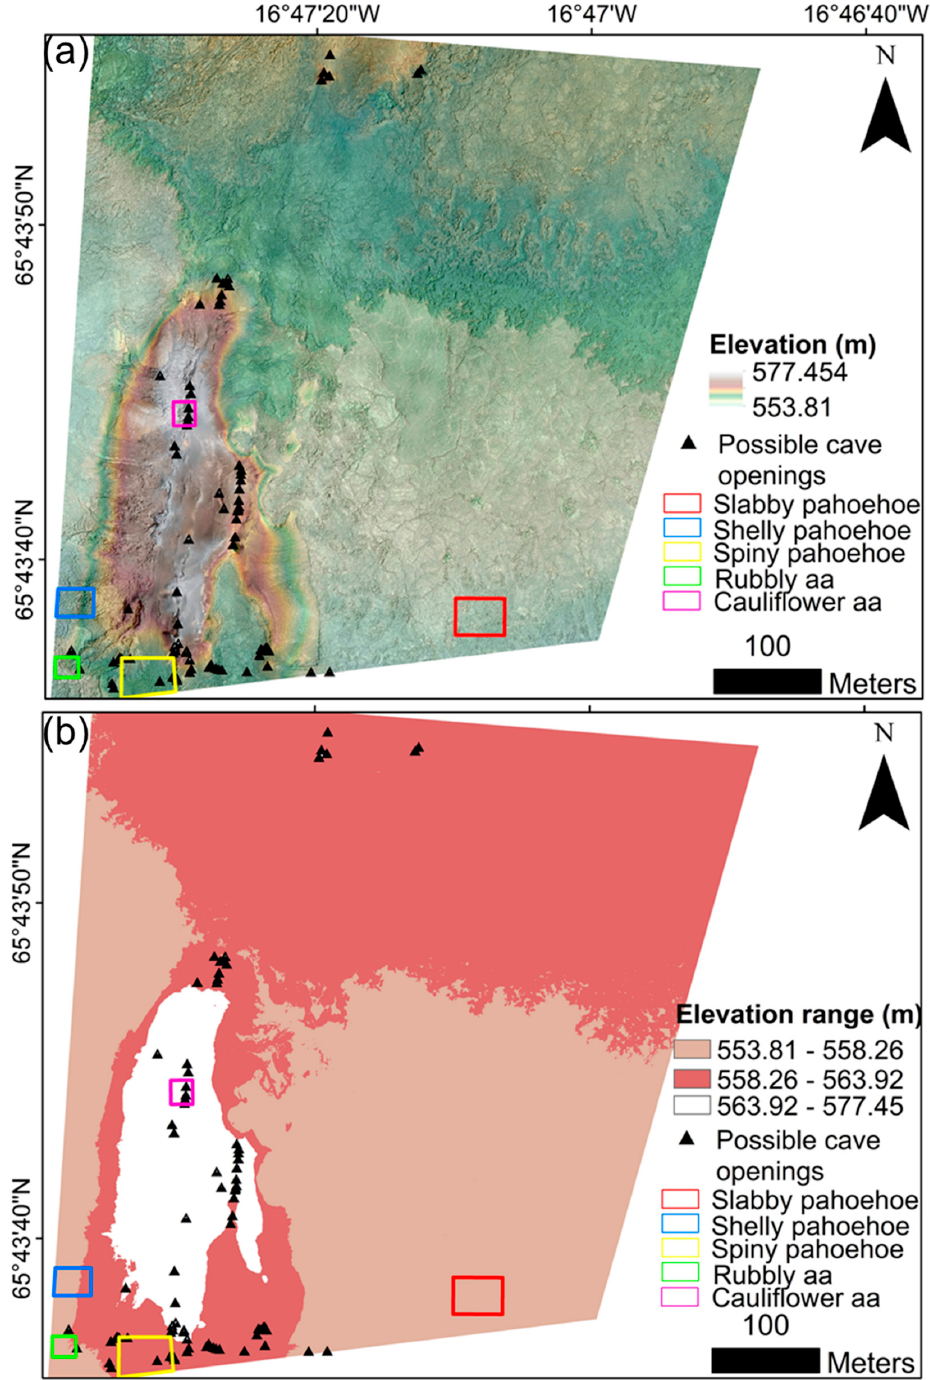
Figure 5. Mapped portion of lava field: ( a ) high-resolution DTM draped over the orthomosaic with marked possible cave openings and sampled lava flow morphologies; ( b ) Natural Breaks-based classification of the DTM to highlight the variations in cave opening density and lava flow morphologies within various elevation ranges. The marked rectangles also provide contextual information for Figures 6 and